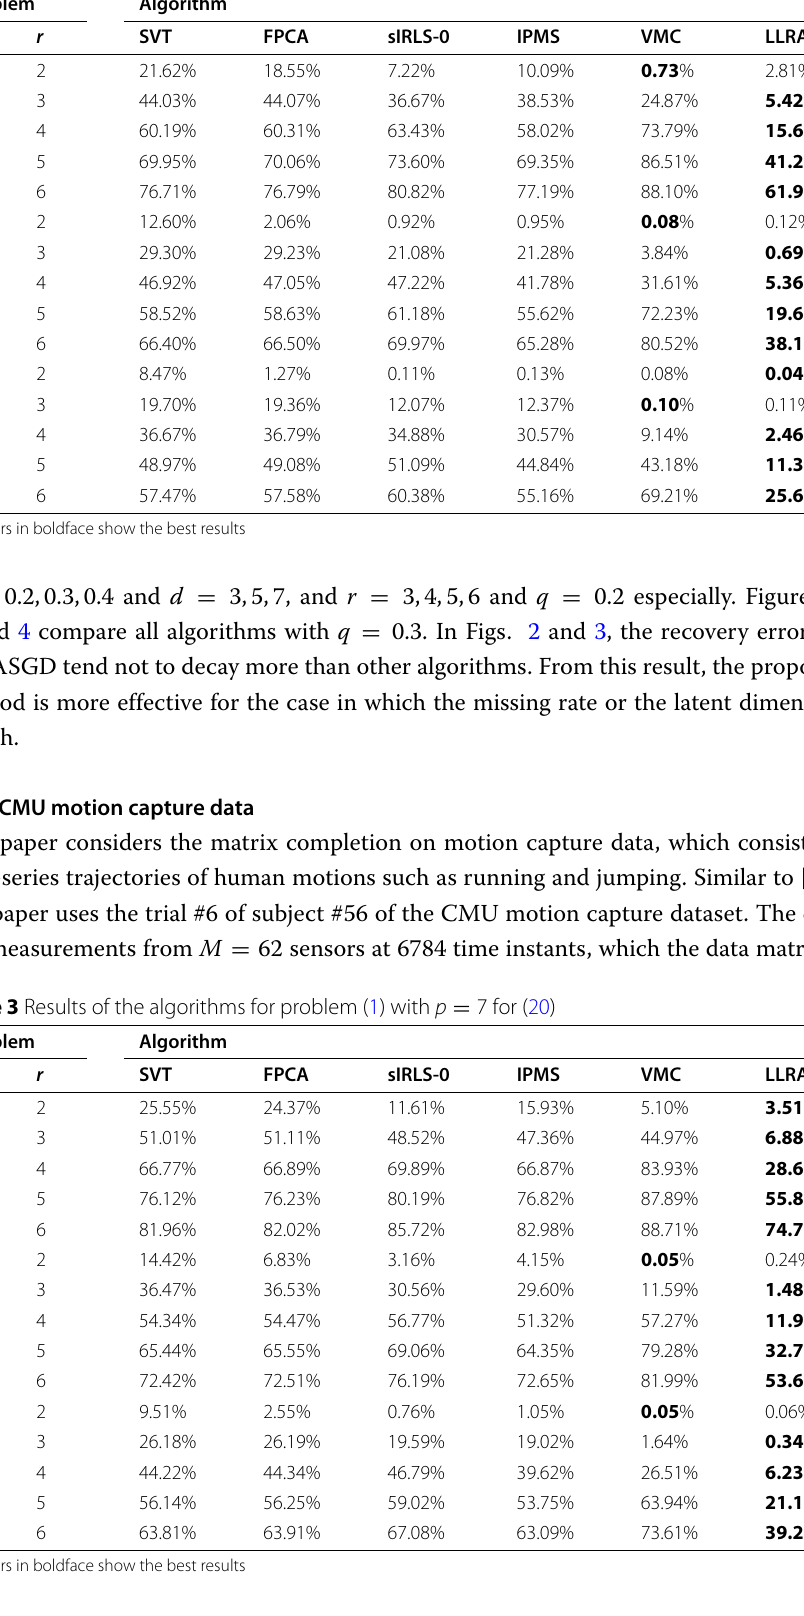
Table 2 Results of the algorithms for problem (1) with p = 5 for (20)